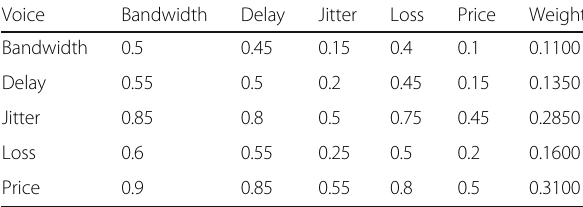
Table 7 Fuzzy consistent matrix and weights for voice